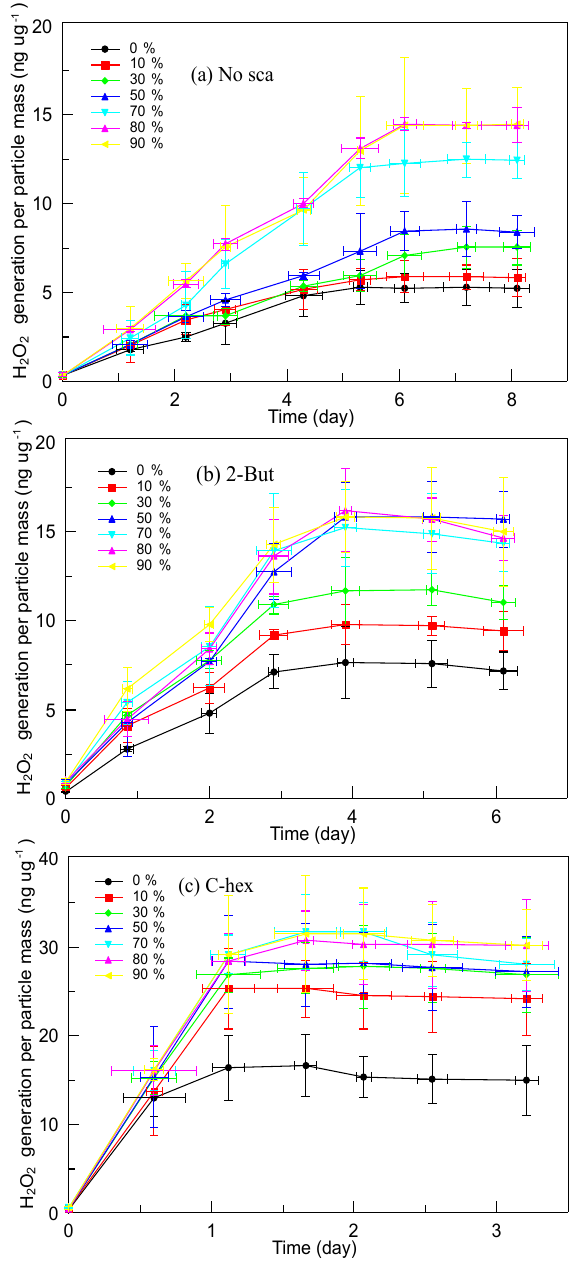
Figure 4. Time profiles of H 2 O 2 evolution per particle mass of different SOA formed (a) without the OH scavenger, (b) with 2- butanol, and (c) with cyclohexane in the relative humidity (RH) range of 0%–90% at a high [O 3 ] / [limonene] ratio. H 2 O 2 , hy- drogen peroxide; No-sca, no scavenger; 2-But, 2-butanol; C-hex,